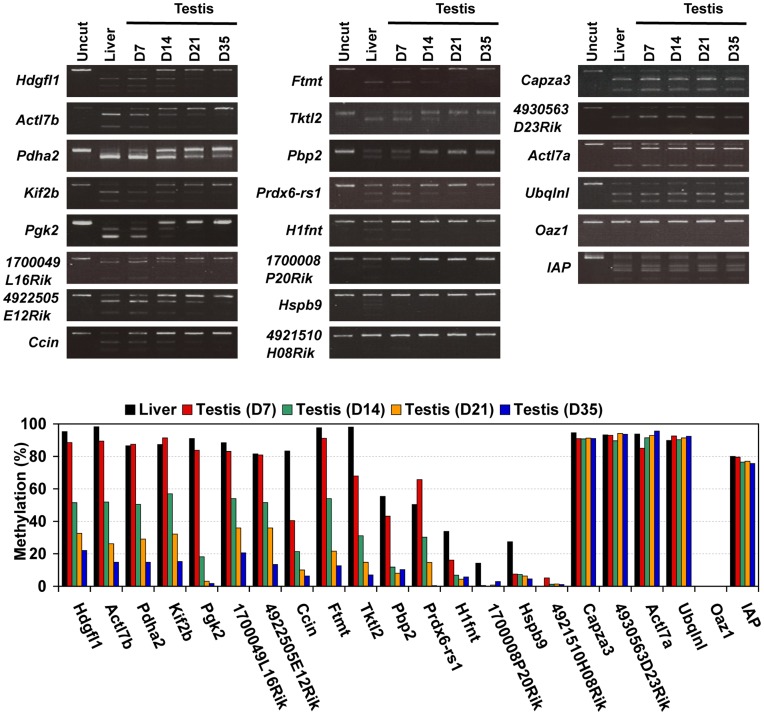
Methylation profiles of spermatogenic cell-specific intronless genes are classified three groups in juvenile mouse testis.COBRA was carried out to examine the methylation status of the selected genes, the CpG island in the Oaz1 gene, and constitutively methylated endogenous IAP retroviruses in genomic DNA isolated from D7, D14, D21, and D35 testes and adult liver. Sodium bisulfite-treated DNA was amplified with specific primers (details in Table S3) and digested with HpyCH4 IV (recognition site: ACGT), Taq I (TCGA) or Acc II (CGCG).